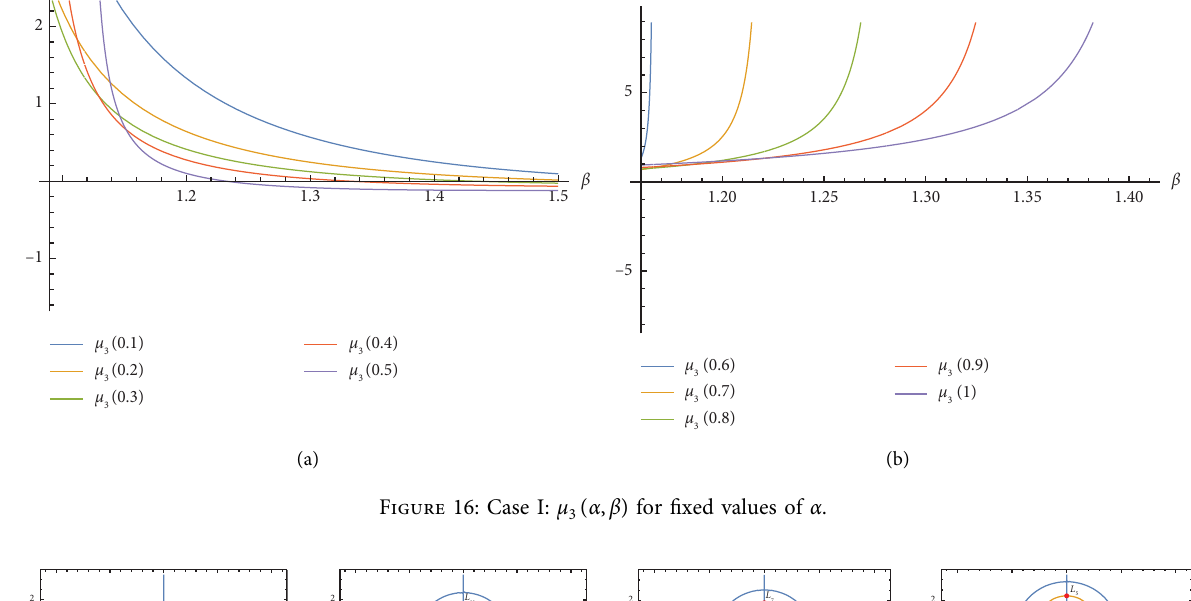
( α , β ) for fxed values of α . 3